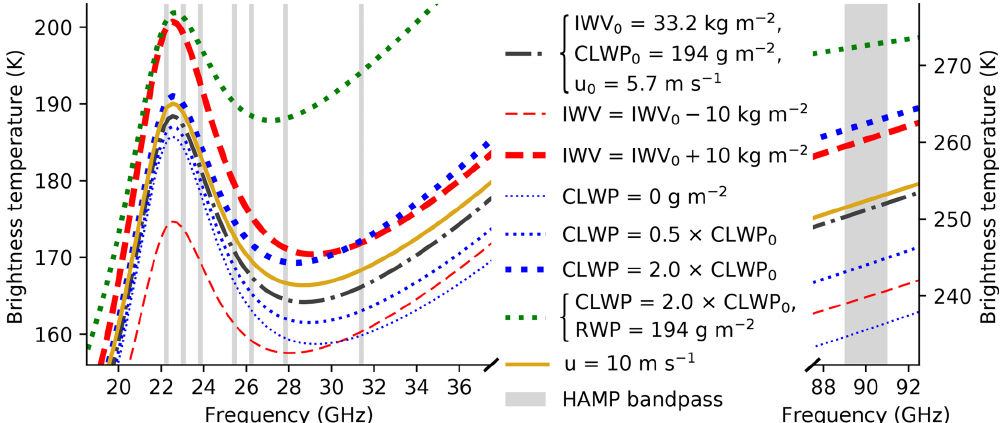
Figure 2. Sensitivity of brightness temperatures in the K band and around 90GHz to integrated water vapor (IWV), cloud liquid (CLWP), and rain water path (RWP), and 10m surface wind ( u ). Dashed, dotted, and solid lines show variations in IWV and LWP (CLWP or RWP) and u , respectively. Bandpasses of the HALO Microwave Package (HAMP) channels are indicated by gray bars. Calculations are based on a thermodynamic dropsonde profile and a synthetic cloud in nadir geometry above the